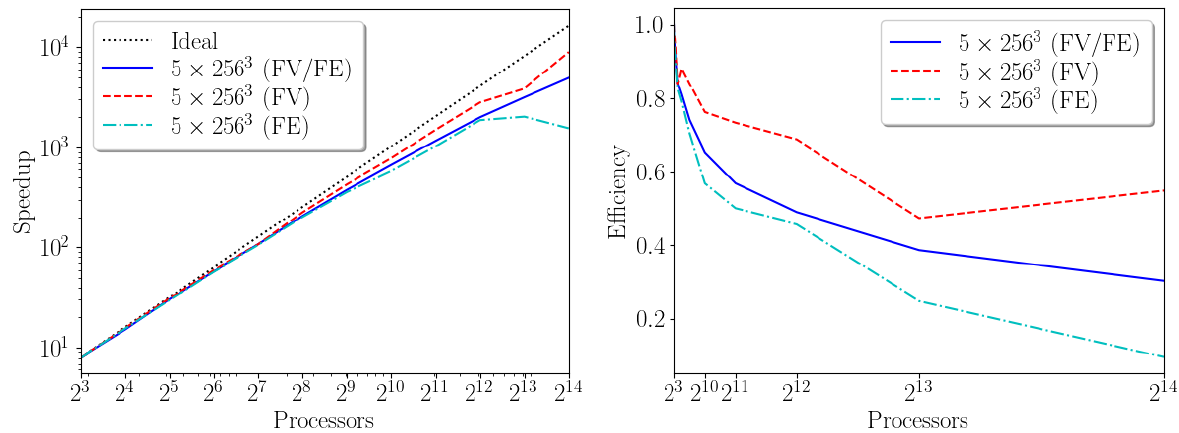
Figure 7. Comparative of the wall-clock time ( left ) and the efficiency ( right ) considering the hybrid FV/FE method (solid blue line), finite volumes (dashed red line) and finite elements (dash-dotted cyan line) to solve the TGV benchmark with 5 256 3 = 83,886,080 primal ×